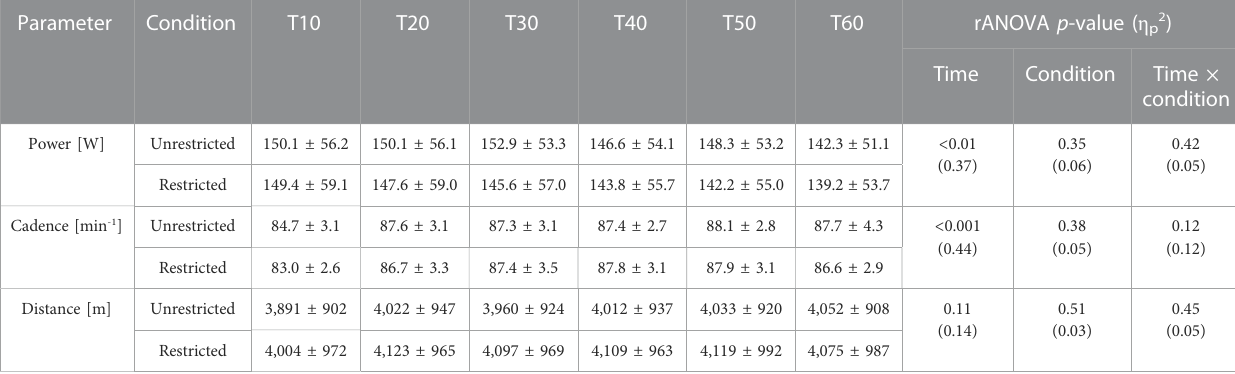
TABLE 1 Performance data (mean value ± standard deviation) for the restricted (nasal-only) and unrestricted condition at each 10min interval (T10-T60). p -Values and partial eta squared ( η p 2 ) of rANOVA are also provided.